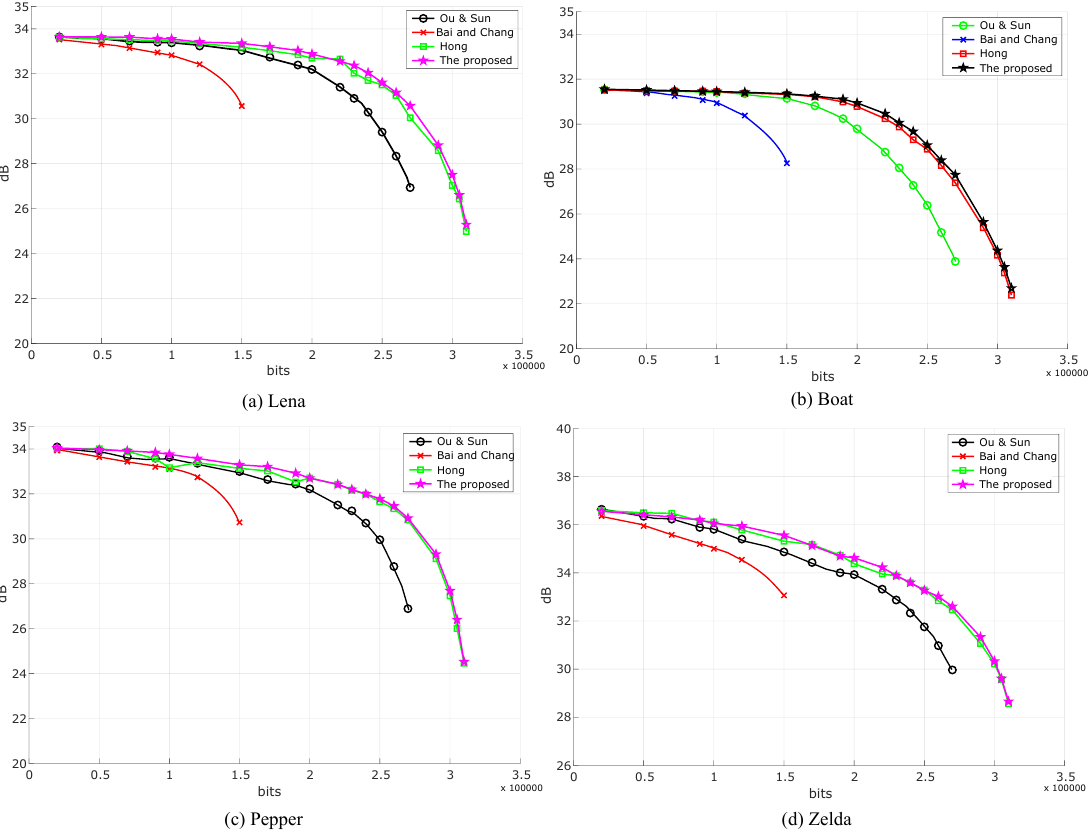
Figure 8. Performance comparisons of the proposed method and other related methods (i.e., Ou and Sun, Bai and Chang, Hong) based on four images: ( a ) Lena, ( b ) Boat, ( c ) Pepper, and ( d )